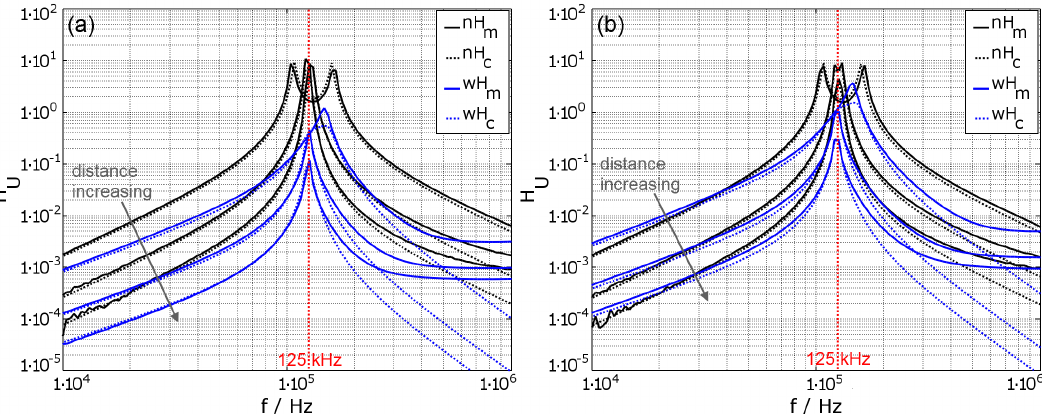
Figure 7. Comparison of the forward voltage transfer function into the implant ( a ) and the reverse voltage transfer function out of the implant ( b ) in a typical inductive transmission without housing (nH) in black and with conductive housing (wH) in blue, – for the measured (m) and - - for the calculated ( c ) results. The used coil parameters for coils ’A’ and ’B’ are N B = N A = 200, Table A1) and the distance between the coils increases from 10mm over 50mm to